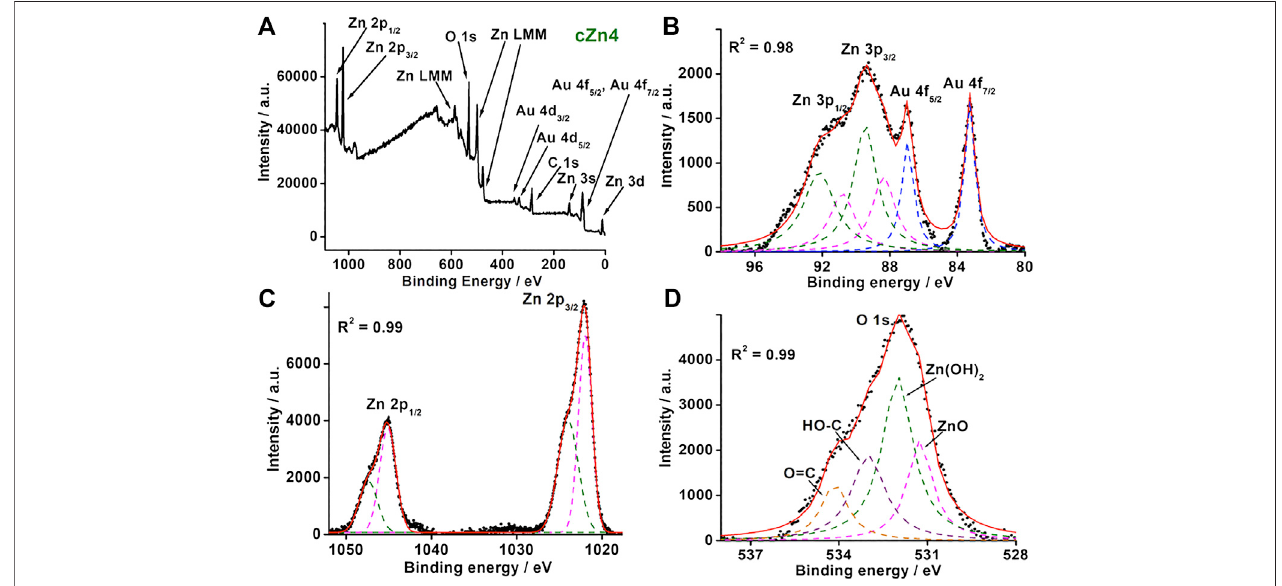
FIGURE 3 | (A) Survey XPS spectrum and (B – D) high-resolution XPS spectra for Au 4f, Zn 3p, Zn 2p, and O 1s of nanocomposite cZn4 .